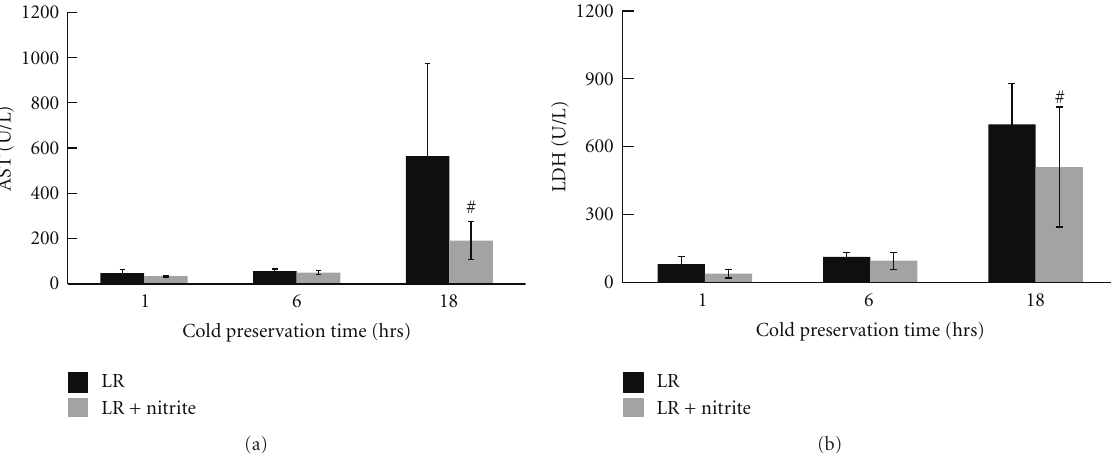
Figure 2: Nitrite-supplemented LR decreased graft enzyme release. LR supplemented with 25 µ M anion nitrite significantly decreased enzyme release at 18 hours (AST—599 ± 492 versus 178 ± 59; LDH—692 ± 269 versus 498 ± 272). Data are expressed as mean ± SE. # P < 0 . 05 for corresponding